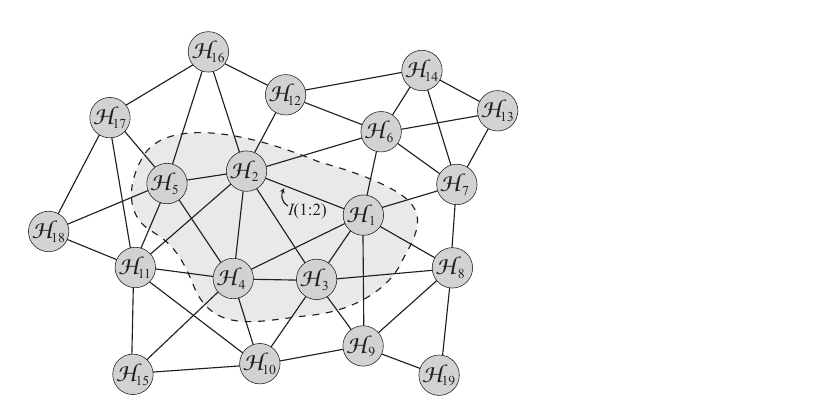
Figure 1. A weighted “information graph” created from a quantum state living in a factorizable Hilbert